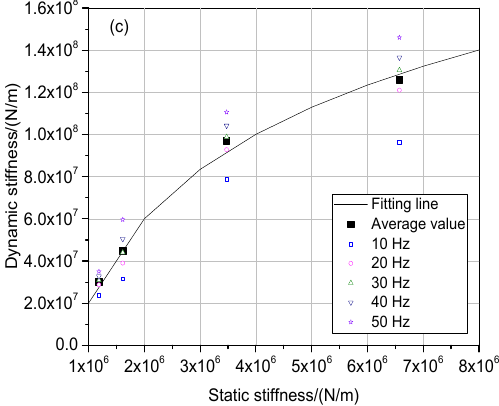
Figure 19. Relationship between the dynamic and static stiffnesses: ( a ) spread foundation; ( b ) caisson foundation; and ( c ) grouped pile foundation.